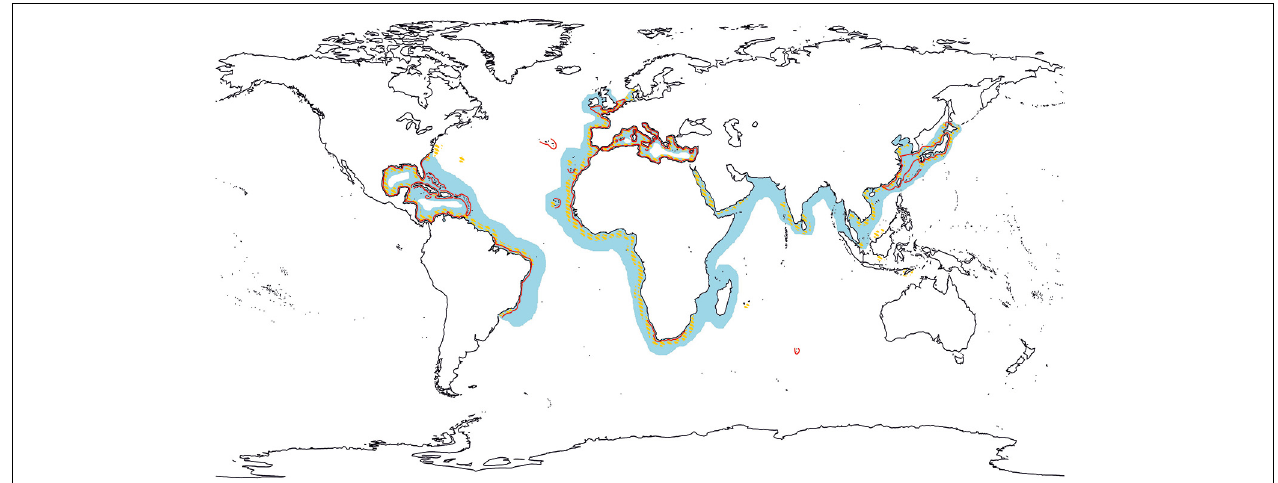
FIGURE 1 | Distribution of O. vulgaris after Mangold (1983), Roper et al. (1984) and Norman et al. (2013), in orange, light blue and red